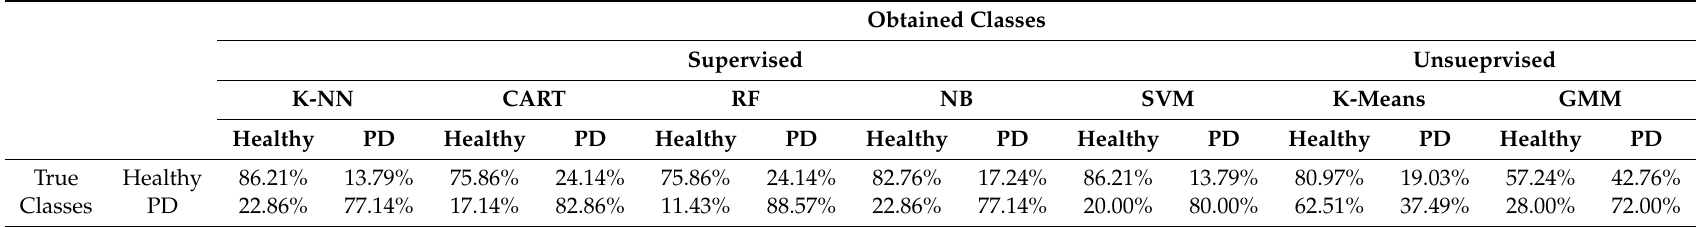
Table 10. Global confusion matrix obtained using the different classifiers in the case of the Frenkel-Toledo et al.